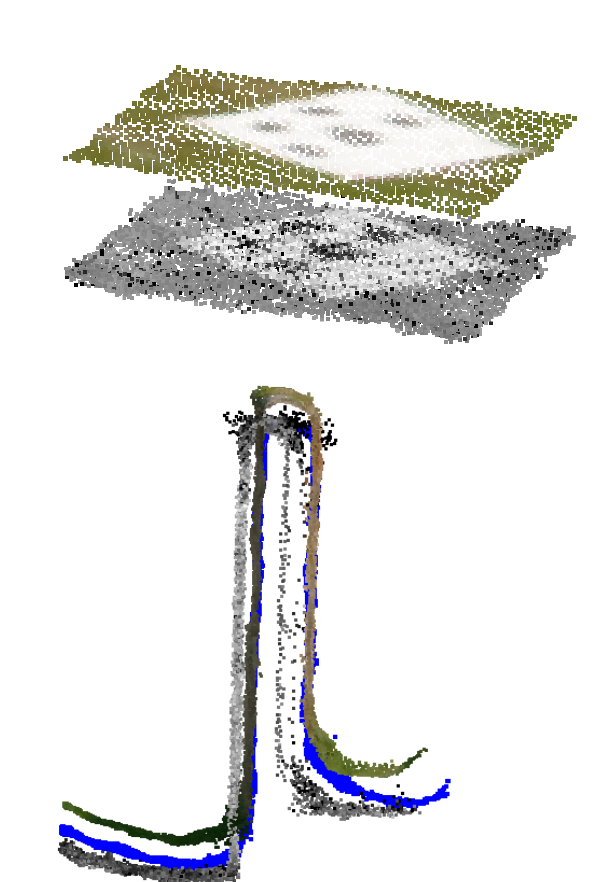
Figure 6. The top shows the PCs from photogrammetric with GCPs and VUX-120 for the target no. 5. The bottom represents the PCs for photogrammetric with and without GCP, and VUX-120 over a wall